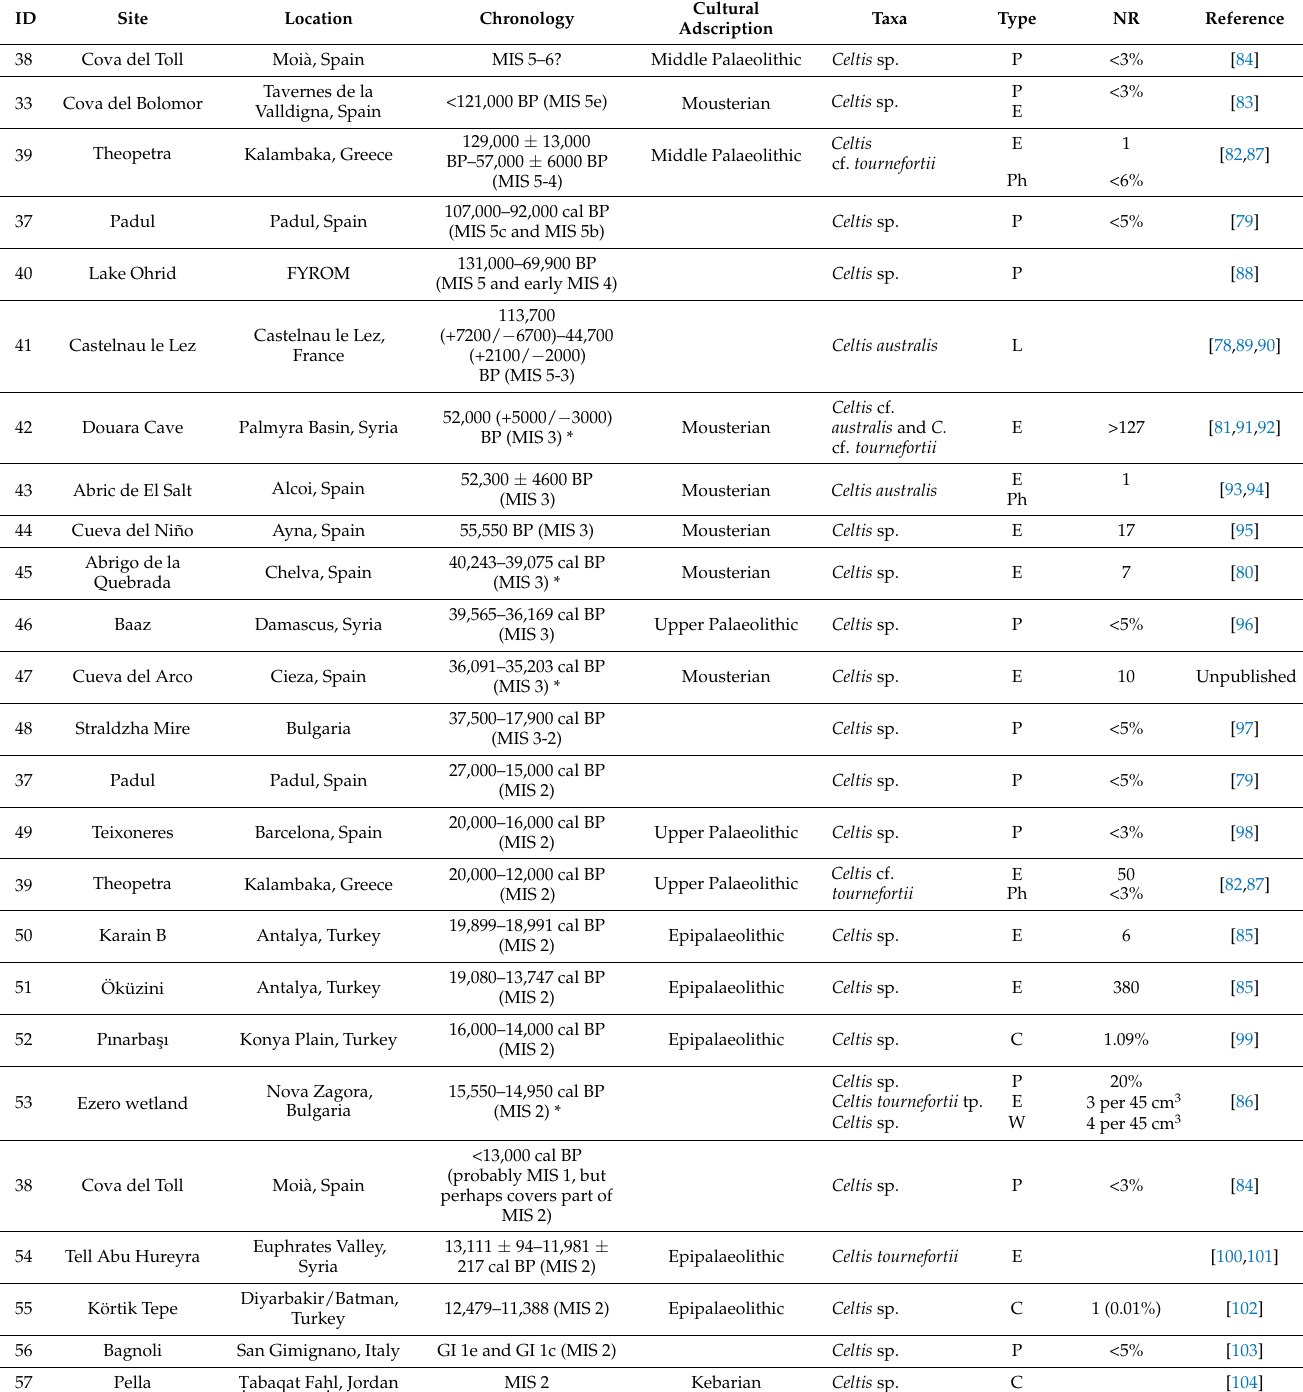
Table 3. Upper Pleistocene sites where Celtis remains were reported (types of remains: wood